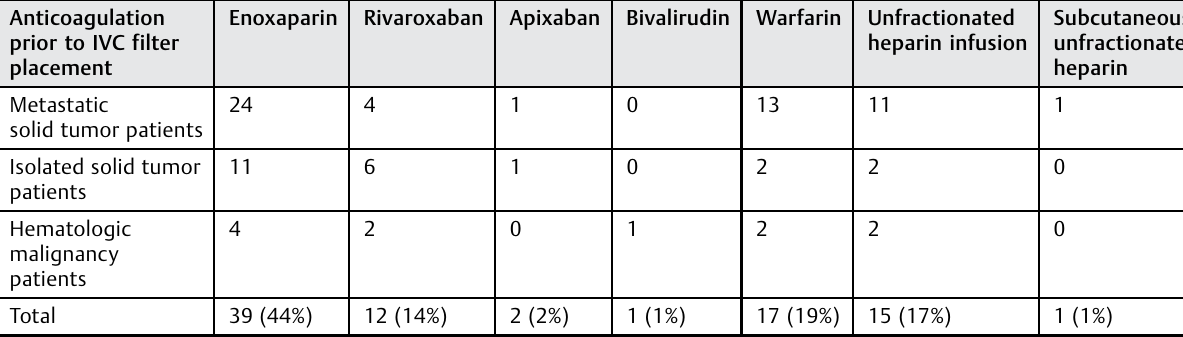
Table 2 Description of anticoagulation therapies of patients prior to IVC fi lter placement Anticoagulation prior to IVC filter placement